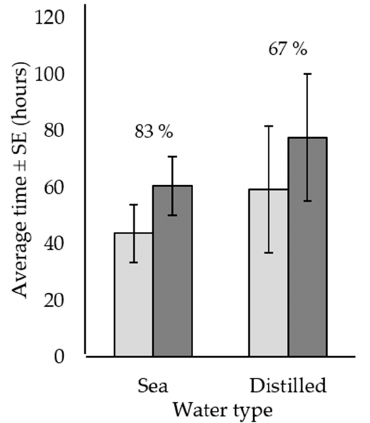
Figure 1. The effects of citric acid concentration and the number of injections. Mean time to immobility ( ) and to death ( ) ± standard error for Acanthaster cf. solaris injected with 20 mL of citric acid and seawater solution at concentrations of 90, 120, and 150 g L − 1 in one ( i ), two ( ii ) and four ( iii ) injection sites (I.S.). Numbers above bars represent total percent mortality; where no numbers are shown, mortality was equal to 100%. For the 150 g L − 1 , 4 I.S. treatment, time to immobility was assumed to equal time to death ( ). Six replicates per treatment combination were used. Letter notations above bars (a, b, c) indicate Tukey’s post-hoc groupings between injection site treatments and concentrations for time to death. Different letters indicate significant differences among treatments.